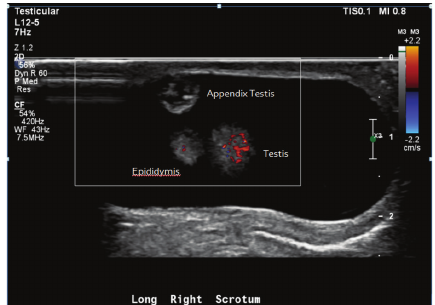
Figure 2: Doppler ultrasonography revealed no blood flow to the appendix testis. Normal blood flow to the testis and epididymis were demonstrated. Right hydrocele was also identified.